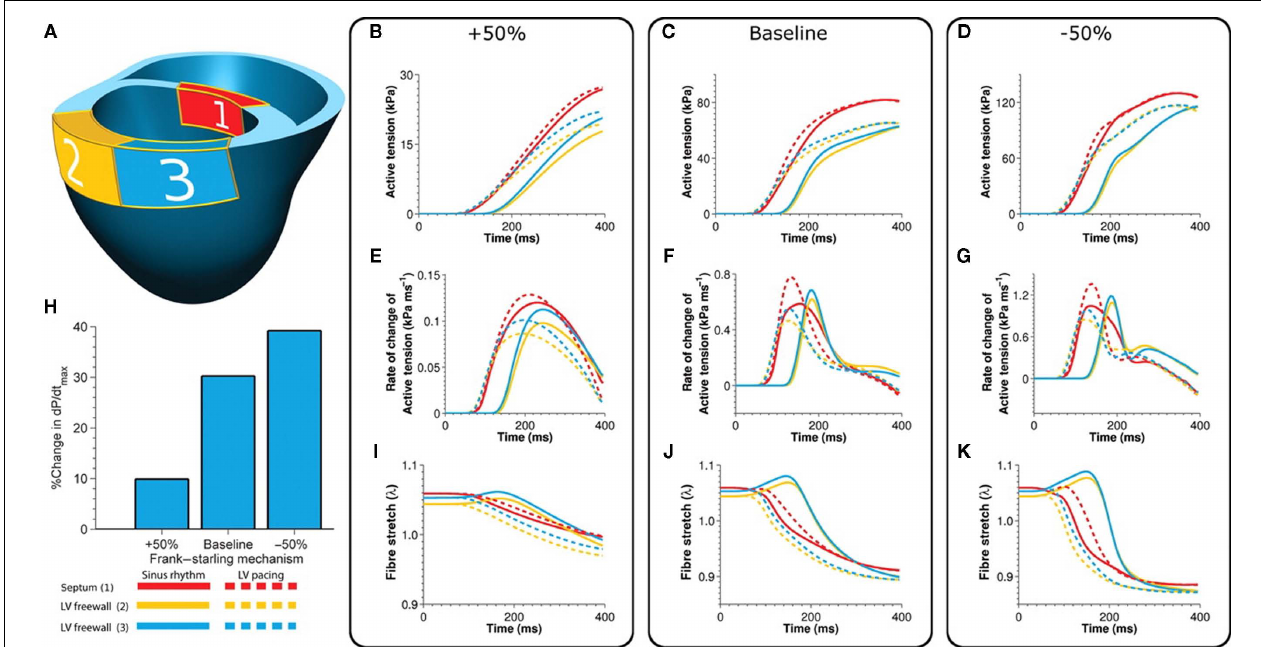
correspond to paced and sinus rhythm activations. (B–D) : active tension; (E–G) : rate of change of active tension; (I–K) : fiber stretch. (H) Percentage change in dP / dt max between sinus rhythm and LV pacing for the cases of − 50, 100, and + 50% length-dependent tension regulation. Reprinted with permission from Niederer et al.